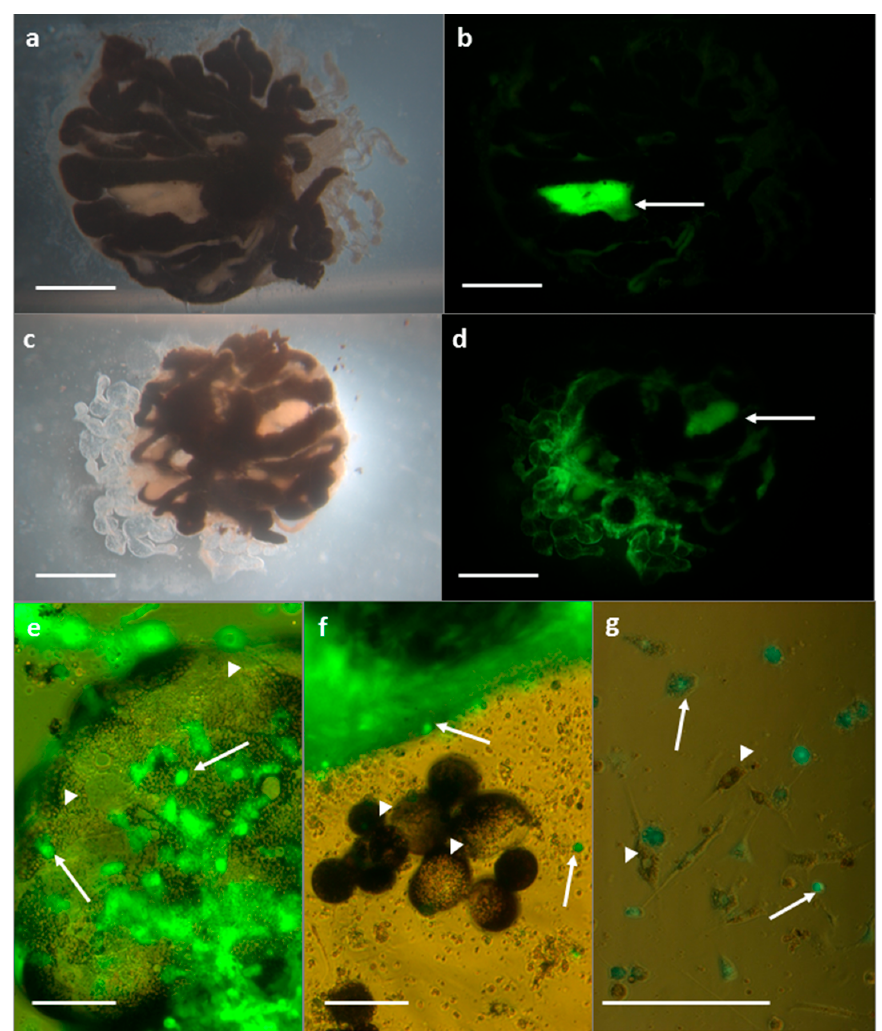
Figure 3. Rhipicephalus evertsi developing adult explants 48 hpi viewed under light ( a , c ), UV ( b , d ), and combined ( e – g ) illumination. (a , b ) Uninfected control explant; arrow indicates autofluorescence of guanine crystals in the rectal sac; scale bars 1 mm; ( c , d ) SFV-infected explant; eGFP fluorescence indicates SFV infection in developing adult tissues; arrow indicates autofluorescence of guanine crystals in the rectal sac; scale bars 1 mm; ( e – g ) SFV-infected explant with green fluorescence indicating virus-infected developing adult tissues and haemocytes (arrows) and absence of fluorescence in midgut cells (arrowheads); scale bars 100 µm.